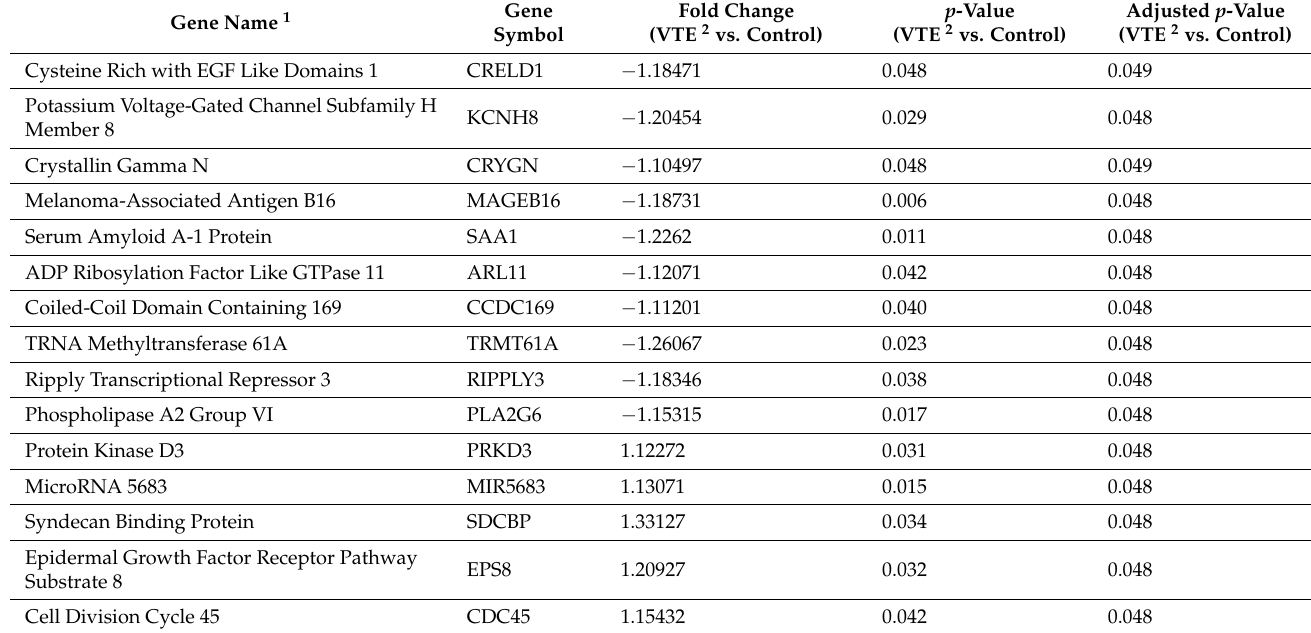
Table 2. Differentially expressed genes between patients with venous thromboembolism and controls, in the diffuse subtype.